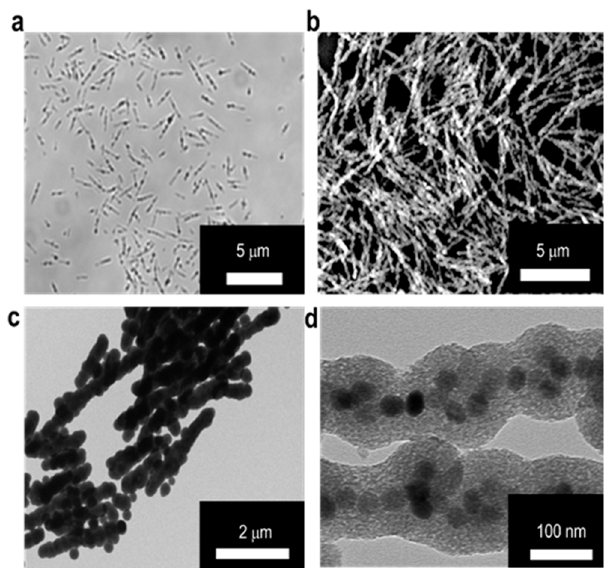
Figure 2. Characterization of microscale silica-coated iron oxide stir bars (MSBs). Morphology of MSBs examined by ( a ) optical microscope in aqueous solution and ( b ) SEM in dry state. ( c ) TEM image of MSBs. Scale bar: 2 μ m. ( d ) HR-TEM image of MSBs. Scale bar: 100 nm.